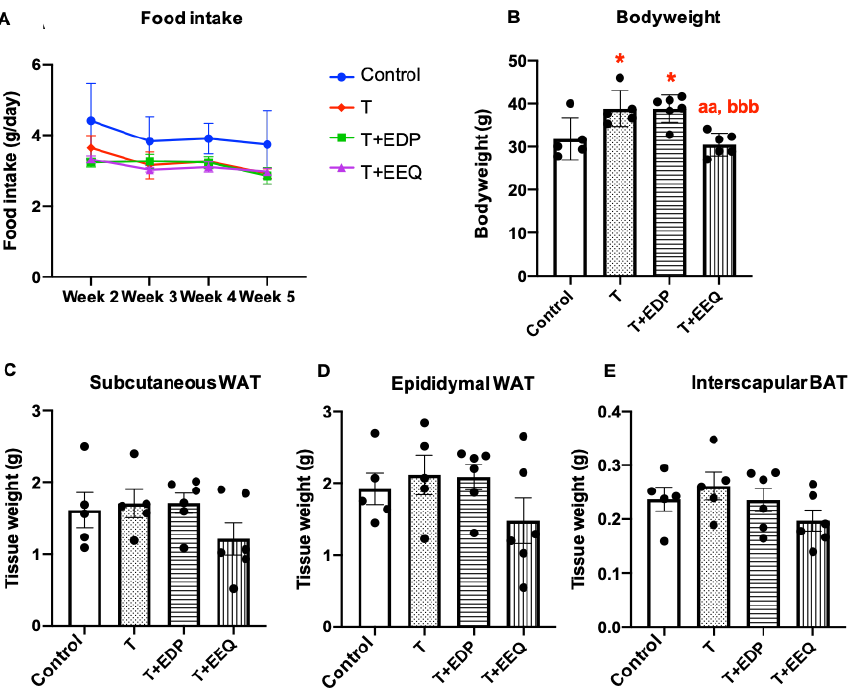
Figure 1. 17,18-EEQ or 19,20-EDP combined with t -TUCB delivered via mini osmotic pump affected bodyweight differentially in diet-induced obesity. Male C57BL/6J mice fed with a high-fat diet (45% kcal from fat) were treated with t -TUCB (3 mg/kg/day) alone or combined with 19,20-EDP (0.05 mg/kg/day) (T + EDP) or 17,18-EEQ (0.05 mg/kg/day) (T + EEQ) by osmotic minipump implantation for 6 weeks, as described in the methods section. Average daily food intake after implantation ( A ), bodyweight ( B ), subcutaneous WAT ( C ), epididymal WAT ( D ), and interscapular BAT weight ( E ) at the end of 6 weeks are shown. Data = the mean ± SEM ( n = 5–6). * = p < 0.05 compared to the controls. aa = p < 0.01 compared to the T group. bbb = p < 0.001 compared to the T + EDP group.